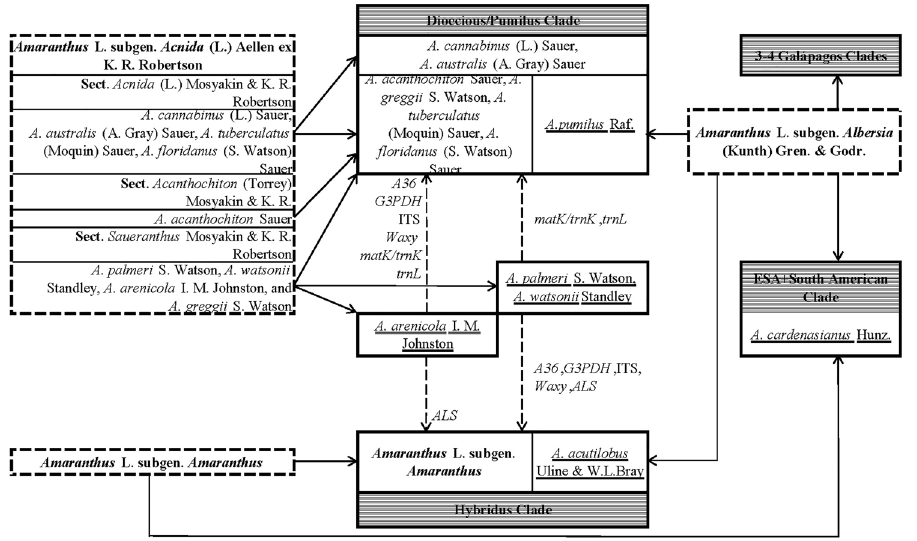
Figure 1. The research status of phylogenetic relationship at the subgenus level in Amaranthus . The dotted boxes indicate the traditional three subgenera of Amaranthus , the horizontal stripes boxes are the four main clades divided by Waselkov et al. based on nuclear and chloroplast gene sequences. The graphics were drawn using Microsoft Excel of Microsoft Office Professional Plus